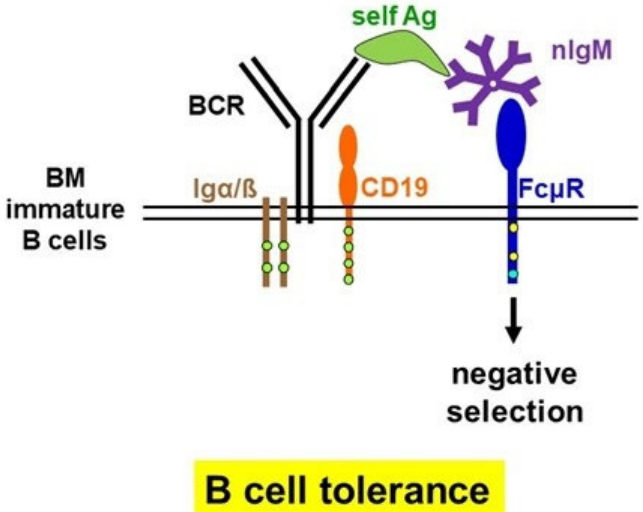
Figure 2. Regulatory role of Fc µ R in B cell tolerance. The common finding in all five strains of Fc µ R-deficient mice is an impairment of B cell tolerance. As a proposed model, the cis engagement of IgM B cell receptor (BCR) and Fc µ R via immune complexes of self-antigen (green) with natural pentameric IgM (purple) on immature B cells in the bone marrow contributes to the negative selection. Ig α /Igß (purple lines) with ITAM (green circles) and CD19 (orange) are also shown. The details are described elsewhere [30].